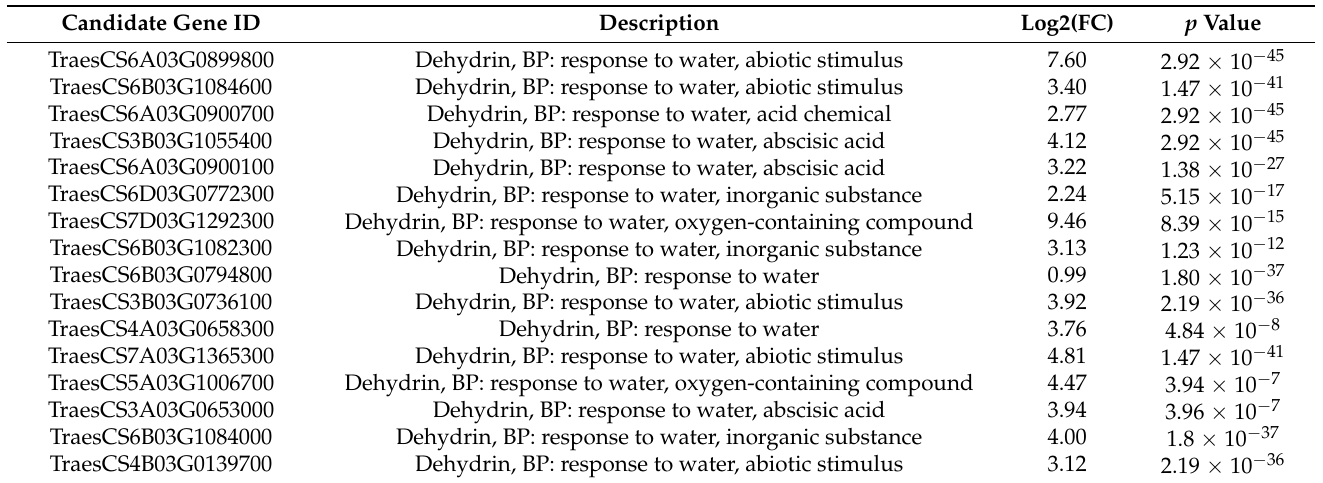
Table 1. Information for the 16 candidate